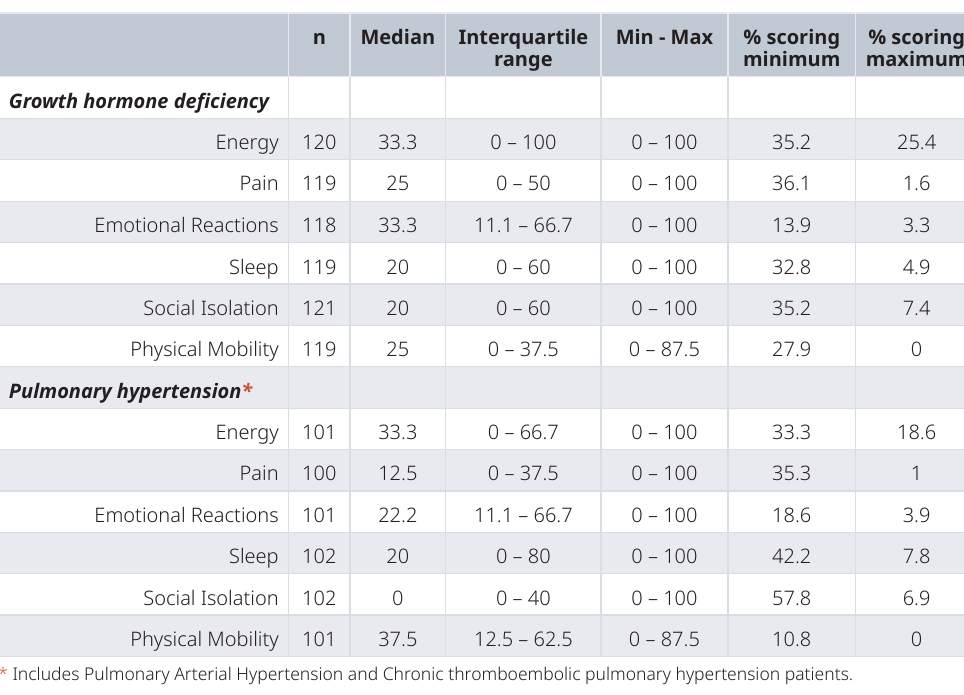
Table 2. Descriptive statistics for NHP sections in adult Growth Hormone Deficiency and Pulmonary Hypertension samples.